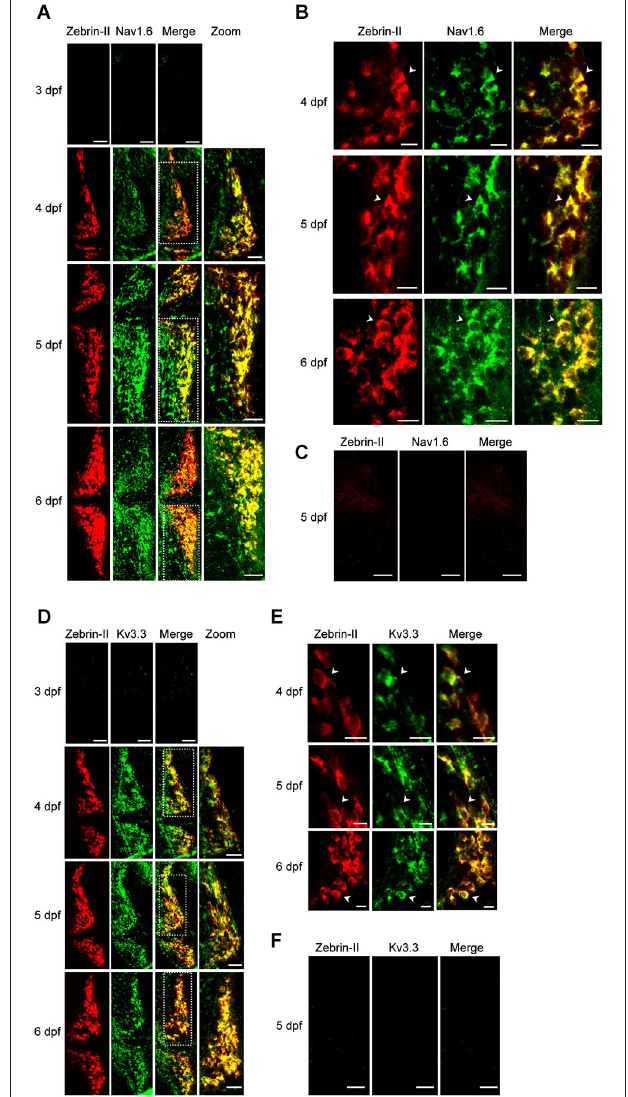
FIGURE 2 | Expression of Nav1.6 and Kv3.3 coincides with the emergence of spontaneous tonic firing in Purkinje cells. (A) Whole mount double fluorescent in situ hybridization was performed on TLN zebrafish at 3, 4, 5, and 6 dpf using digoxigenin-labeled aldoca (Zebrin-II, red) and fluorescein-labeled scn8aa (Nav1.6, green) antisense probes (Thisse and Thisse, 2008; Brend and Holley, 2009). Projected confocal image stacks for aldoca , scn8aa , and merged images are shown in the 3 left-most panels, respectively. Dashed white boxes in merged images denote regions of one cerebellar hemisphere that have been enlarged and shown in the right-most panel (zoom). Here and in subsequent parts of the figure, dorsal views are shown. Anterior is to the left. Scale bars: 40 µ m. (B) Enlarged single optical sections from the projections in Figure 2A at 4, 5, and 6 dpf are shown. Arrowheads identify individual Purkinje cell bodies. Scale bars: 10 µ m. (C) Whole mount double fluorescent in situ hybridization was performed on TLN zebrafish at 5 dpf using digoxigenin-labeled aldoca (Zebrin-II, red, left panel) and fluorescein-labeled scn8aa (Nav1.6, green, center panel) sense probes (Thisse and Thisse, 2008; Brend and Holley, 2009). Merged image is shown in right panel. Scale bar: 40 µ m. (D) Whole mount double fluorescent in situ hybridization was performed on TLN ( Continued